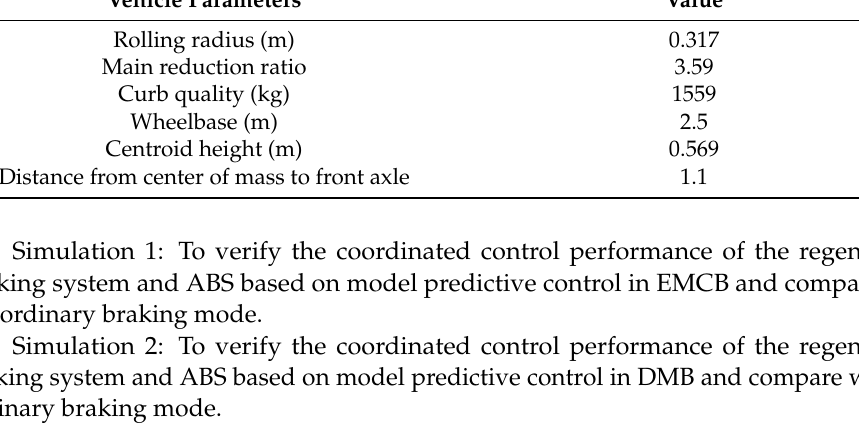
Table 3. Important vehicle parameters for